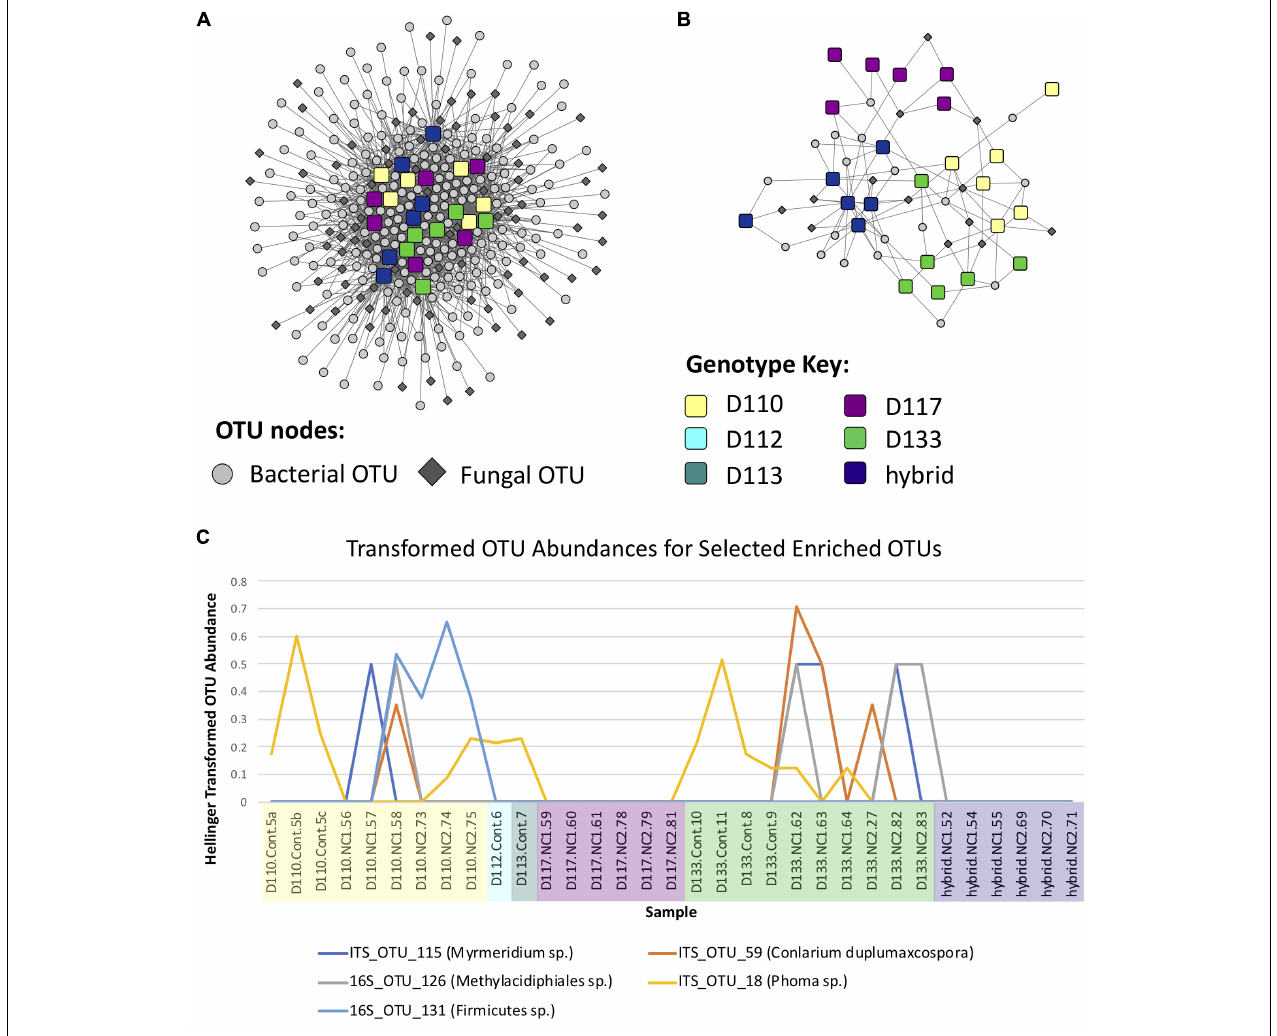
FIGURE 5 | (A) Operational taxonomic unit (OTU)-sample enrichment networks representing the enrichment of OTUs in samples for Experiment 1, determined using the Fisher Exact test. (B) Subnetwork of the enrichment network involving genotype-specific OTUs, i.e., OTUs which were enriched in ≤ 2 genotypes and had a quotient ≥ 2 (see Materials and Methods and Supplementary Table S5 ). (C) Abundance line plots of selected OTUs which appear to be enriched in genotypes D110 and D133.